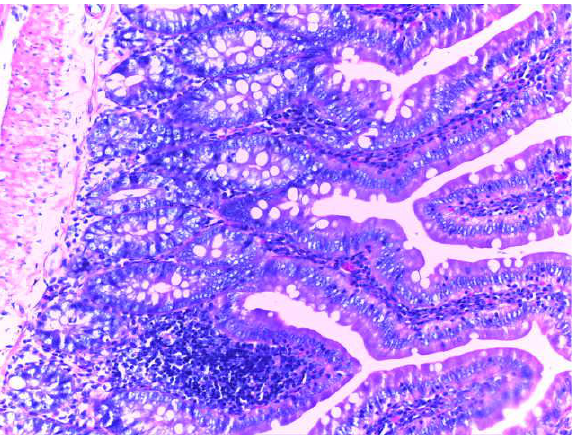
Figure 9. Normal histological appearance of the small intestine in group I (H&E stain, ob 20X). Histological examination of the small intestine in animals treated with diclofenac (group II) revealed an abundant inflammatory infiltrate, even with small lymphoid folli- cles and few neutrophils in the lamina propria. No mucosal erosions are observed, and the submucosa, tunica muscularis and serosa have a normal histological appearance (Fig- ure 10).